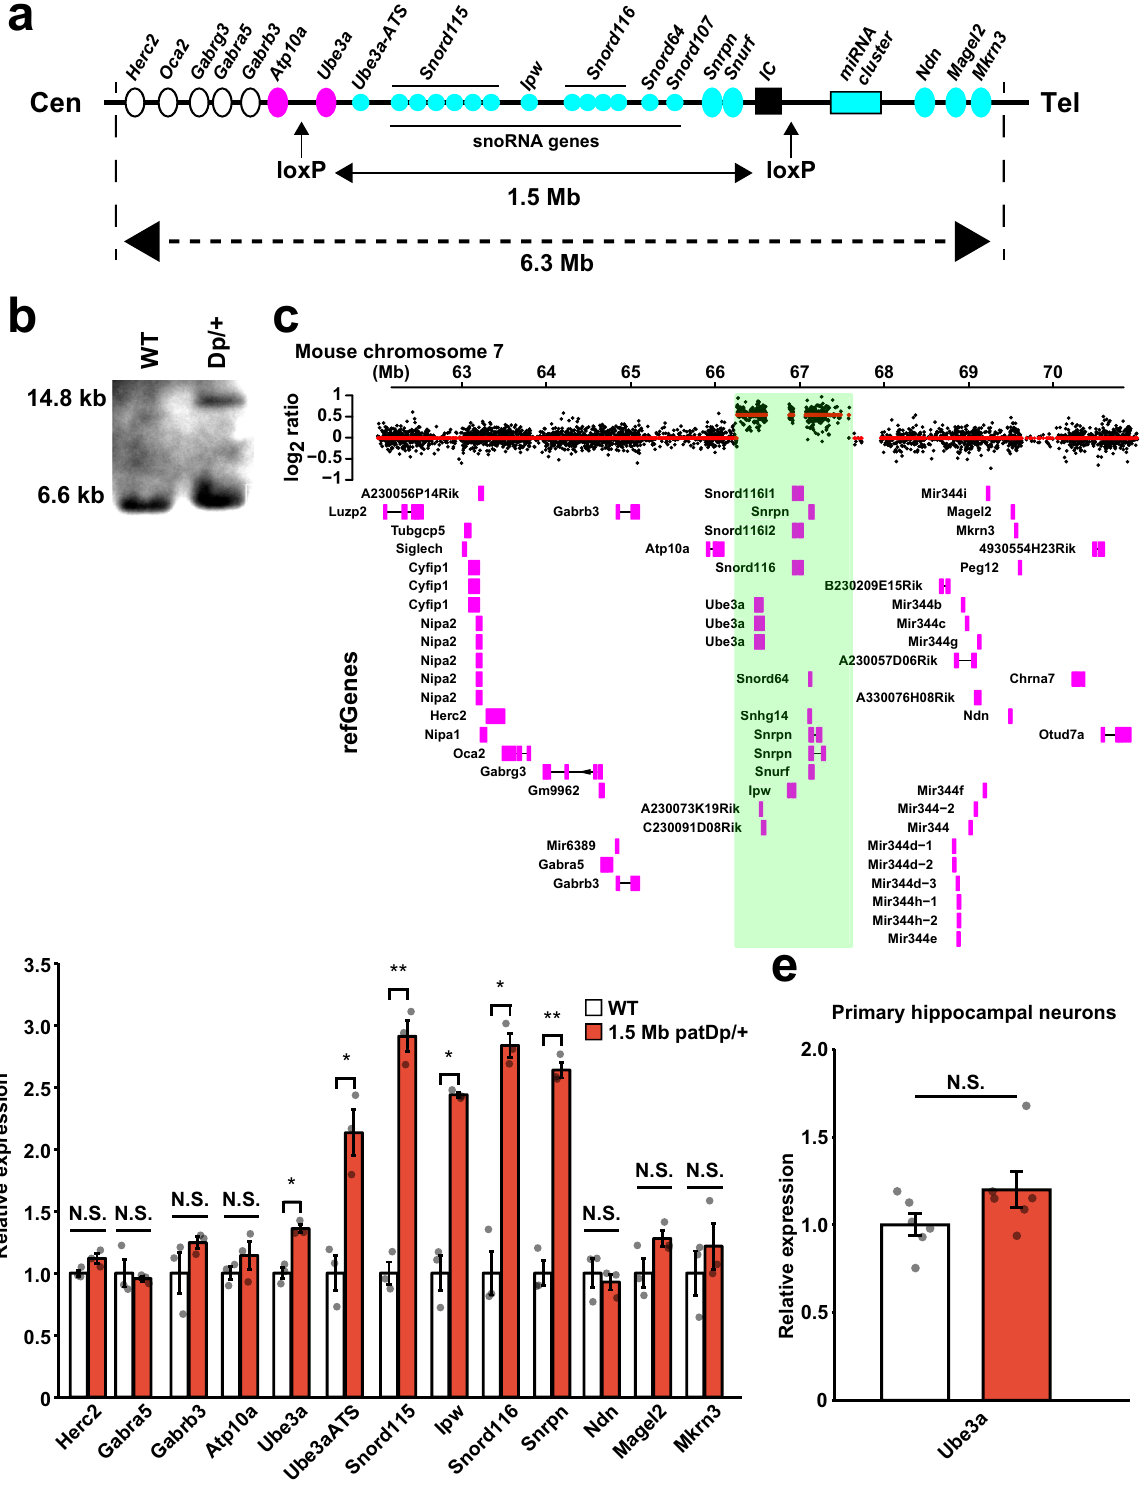
reversal learning task for 4 days (Fig. 2f, g). During the training, the number of errors to reach the correct hole by 1.5 Mb patDp/ + mice was similar as that in WT mice both in spatial and reversal learning tasks (Fig. 2g, p > 0.05; both genotype effect and inter- action with time). To ensure the spatial learning ability in 1.5 Mb patDp/ + mice, a probe trial was conducted after 6 days learning (Fig. 2h, i). Similar to WT mice, 1.5 Mb patDp/ + mice spent more NATURE COMMUNICATIONS| (2021) 12:4056